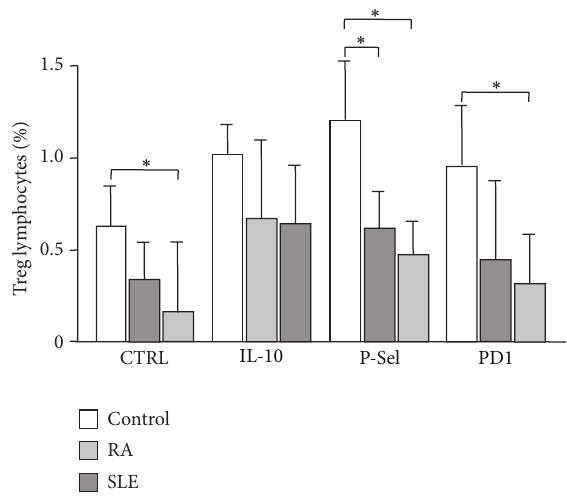
Figure 5: Induction of Treg lymphocytes by mo-DCs from patients withRAandSLE.MonocytederivedDCsgeneratedundertolerizing conditions (PDL-1, PSGL-1 engagement, or IL-10 addition) or not, were cocultured with autologous CD4+ lymphocytes for five days. Then, the percent of CD4+ CD25+ Foxp3+ lymphocytes was determined by flow cytometry. Data correspond to the median and interquartile range of the percent of positive cells. ∗ 𝑃 < 0.05